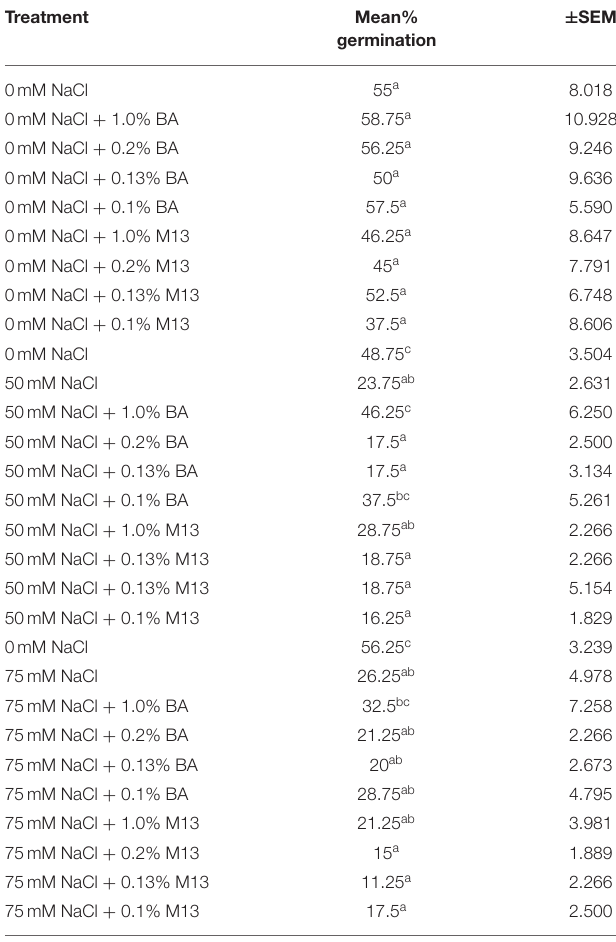
TABLE 5 | Effect of treatment on mean percentage germination of soybean exposed to 0, 50, and 75mM NaCl, for 24h.